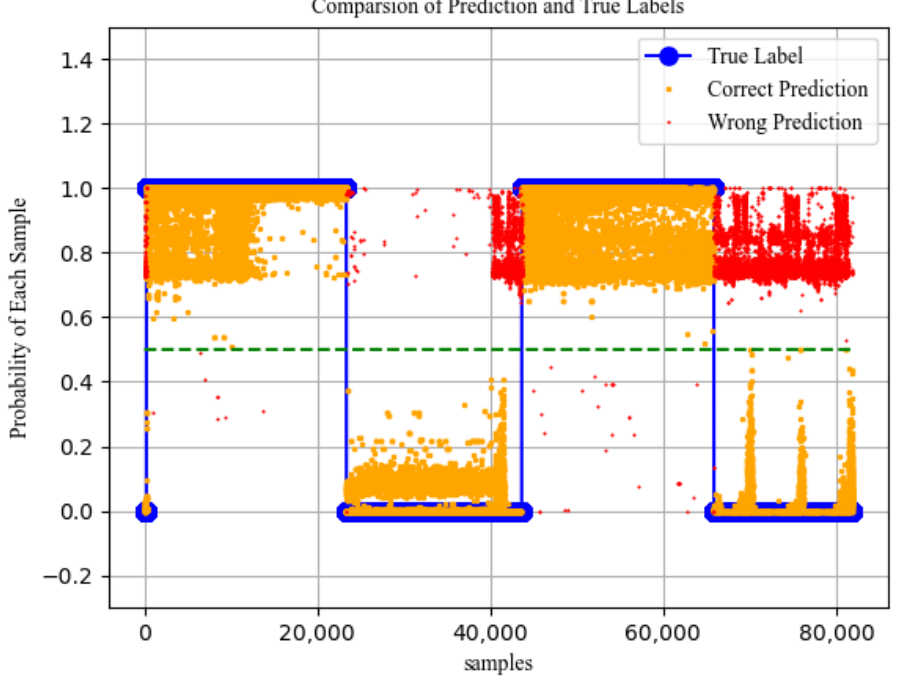
Figure 6. LSTM model fitting